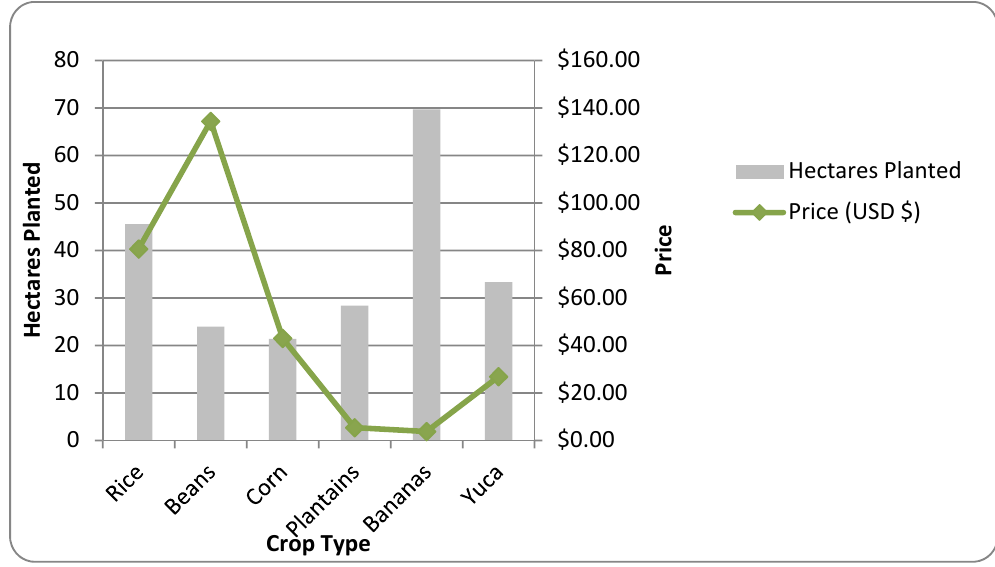
Figure 2. Relationship between price per unit of agricultural product and area planted (n = 90).